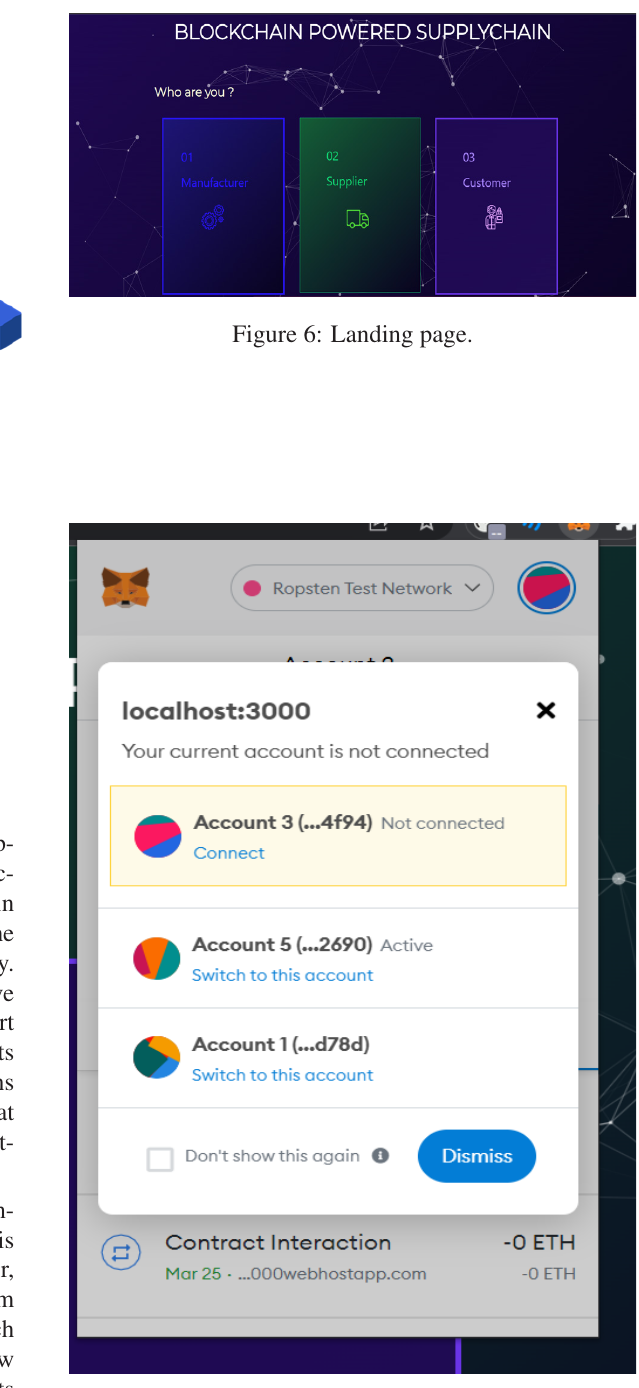
Figure 7: Connecting to Ethereum using Metamask